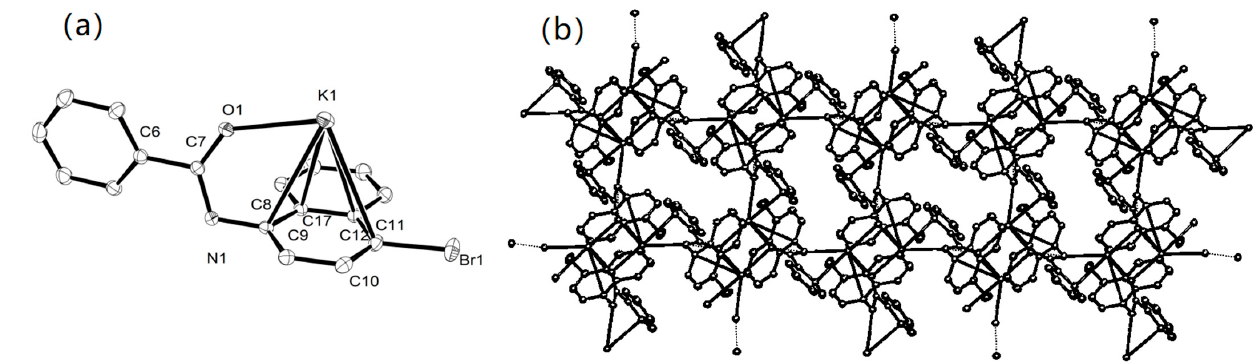
Figure 1. ( a ) Ortep drawing of structure of K2 , ellipsoids are shown at the 30% probability level (left). ( b ) A section of the packing diagram in K2 (right).